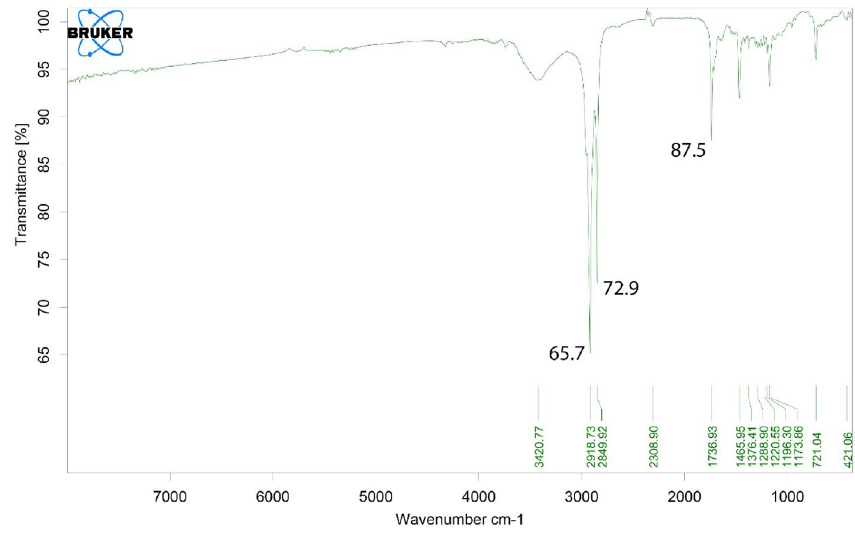
Figure 4. FTIR spectrum, related to bee carcasses/polyaniline/polyethylene glycol composite.